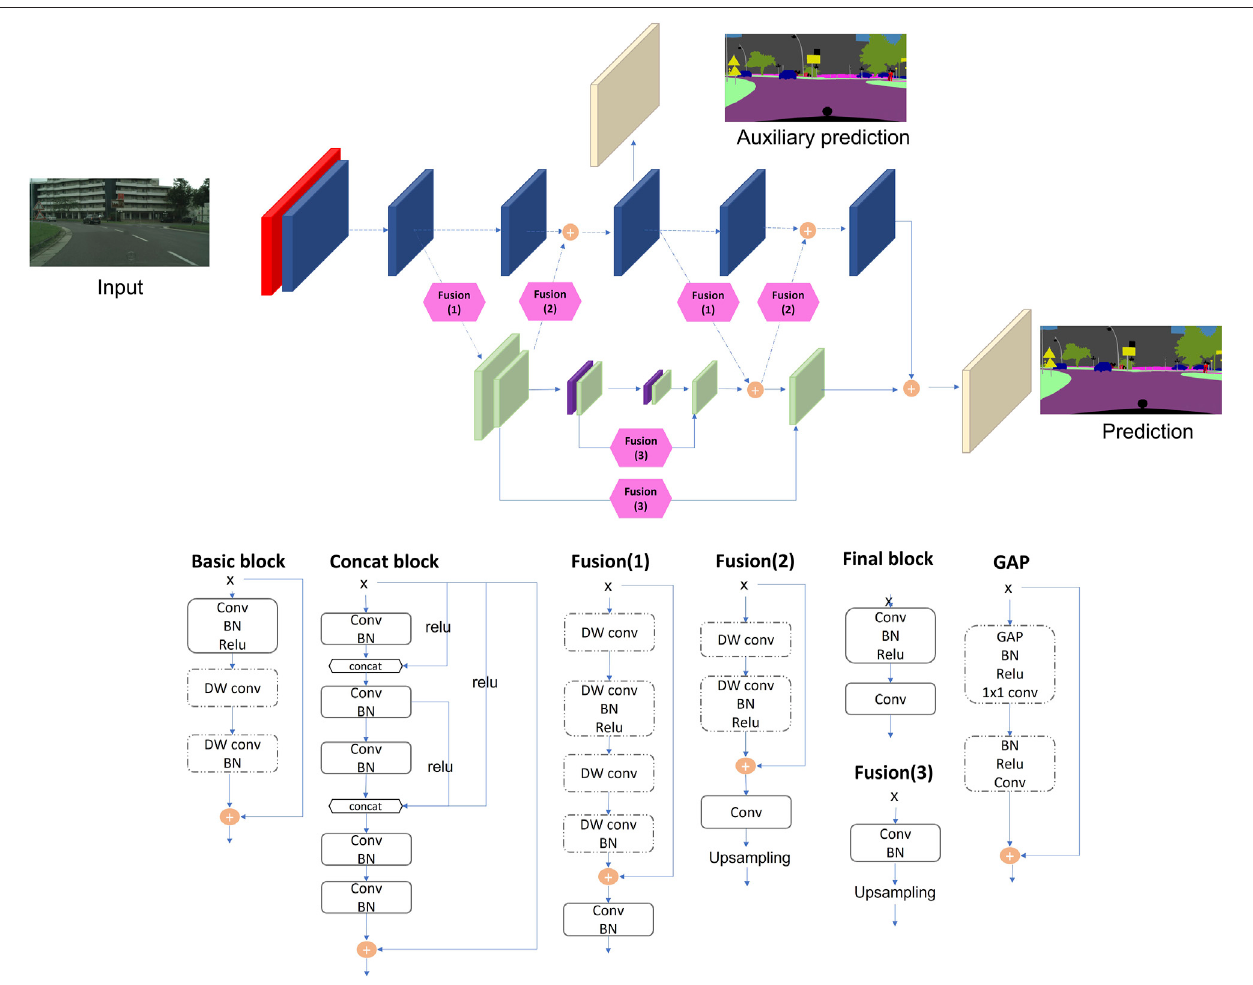
FIGURE 2 | Network architecture. Each color block represents a different module and each module schematic is shown below the architecture diagram. Red — simpleconvolutionlayer;Blue — basicblock;Green — concatblock; Hexagon — upanddown fusion;Purple — globalaveragepooling;Beige — fi nalandextralayer. DW conv, depthwise convolution. BN, batch normalization. Auxillary prediction is solely for training.